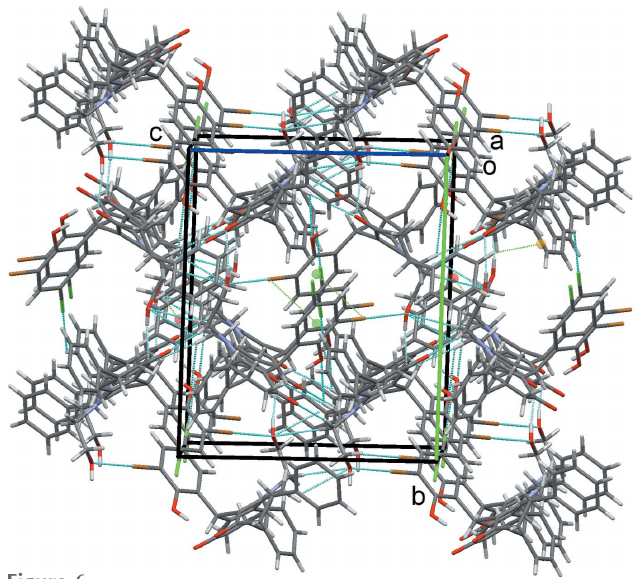
Figure 6 Overall packing of (I) viewed along the a -axis direction.